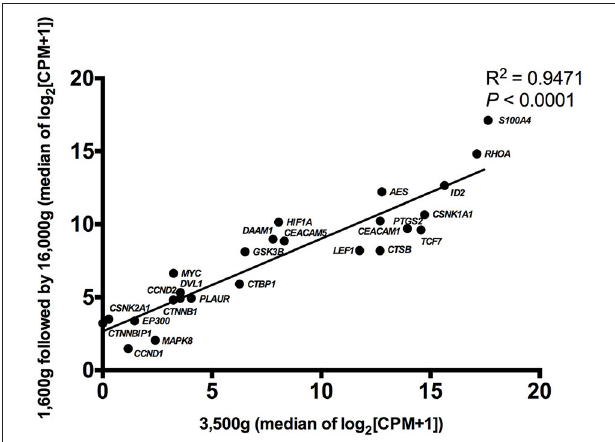
FIGURE 3 | The correlation of gene expressions in two centrifugal forces. The median normalized expressions (log 2 scale) of 25 passed filter genes were correlative between 3,500 and 1,600g followed by 16,000g conditions ( R 2 = 0.9471, P < 0.0001, Spearman rank correlation).